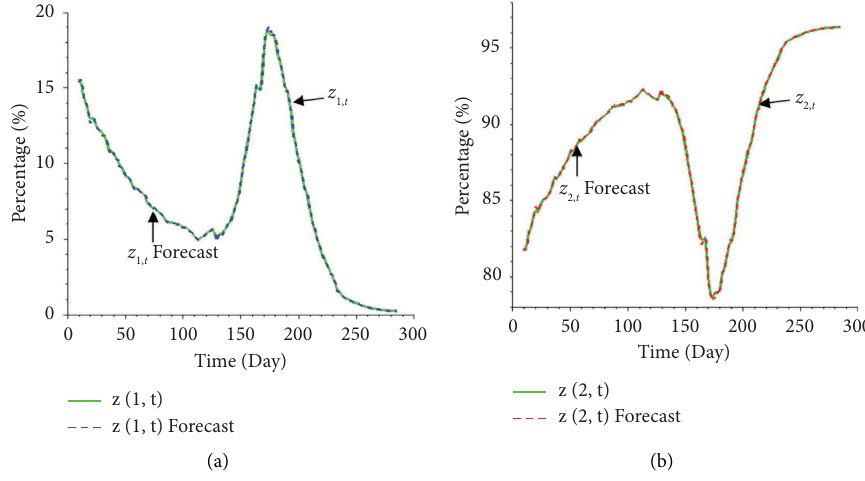
Figure 4: Te visual comparison between the z